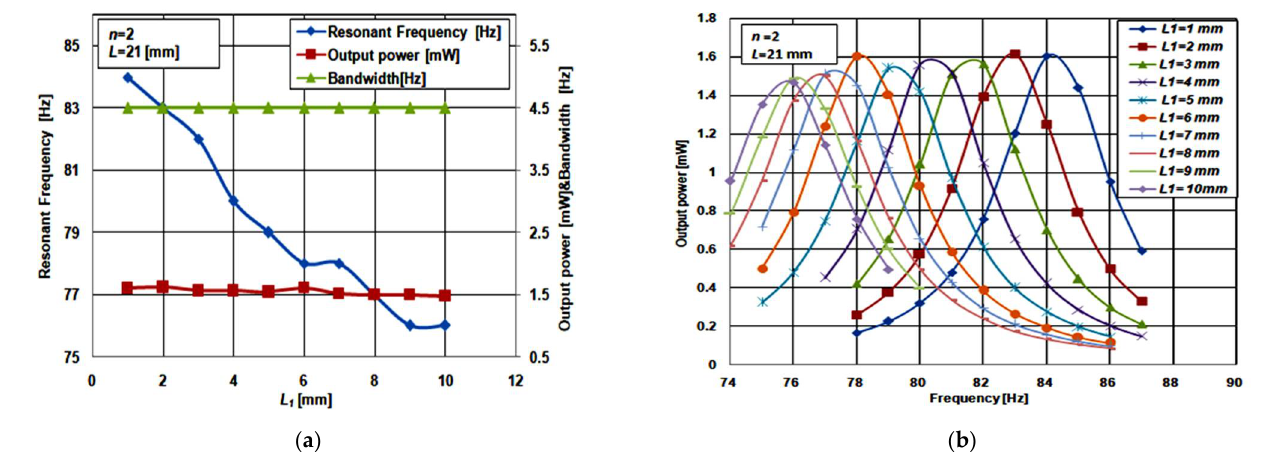
Figure 5. ( a ) Effect of changing L 1 on the resonant frequency, output power and bandwidth and ( b ) frequency response at various values of L 1 .